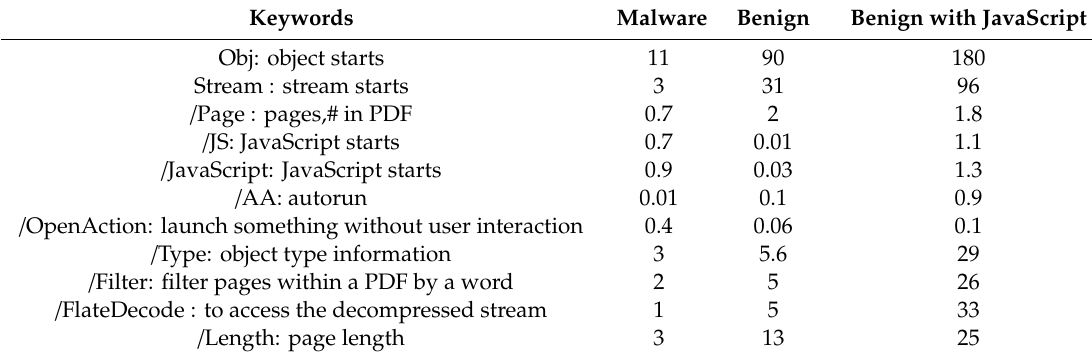
Table 2. The average count of each keyword appearance per a document.